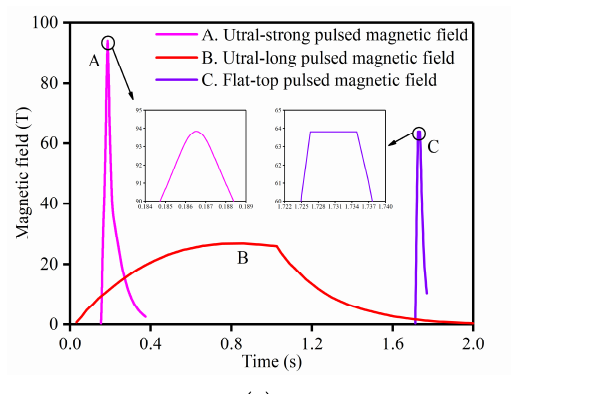
Figure 1. Typical pulsed and permanent magnetic field waveforms. ( a ) Pulsed magnetic field; ( b ) permanent magnetic field.